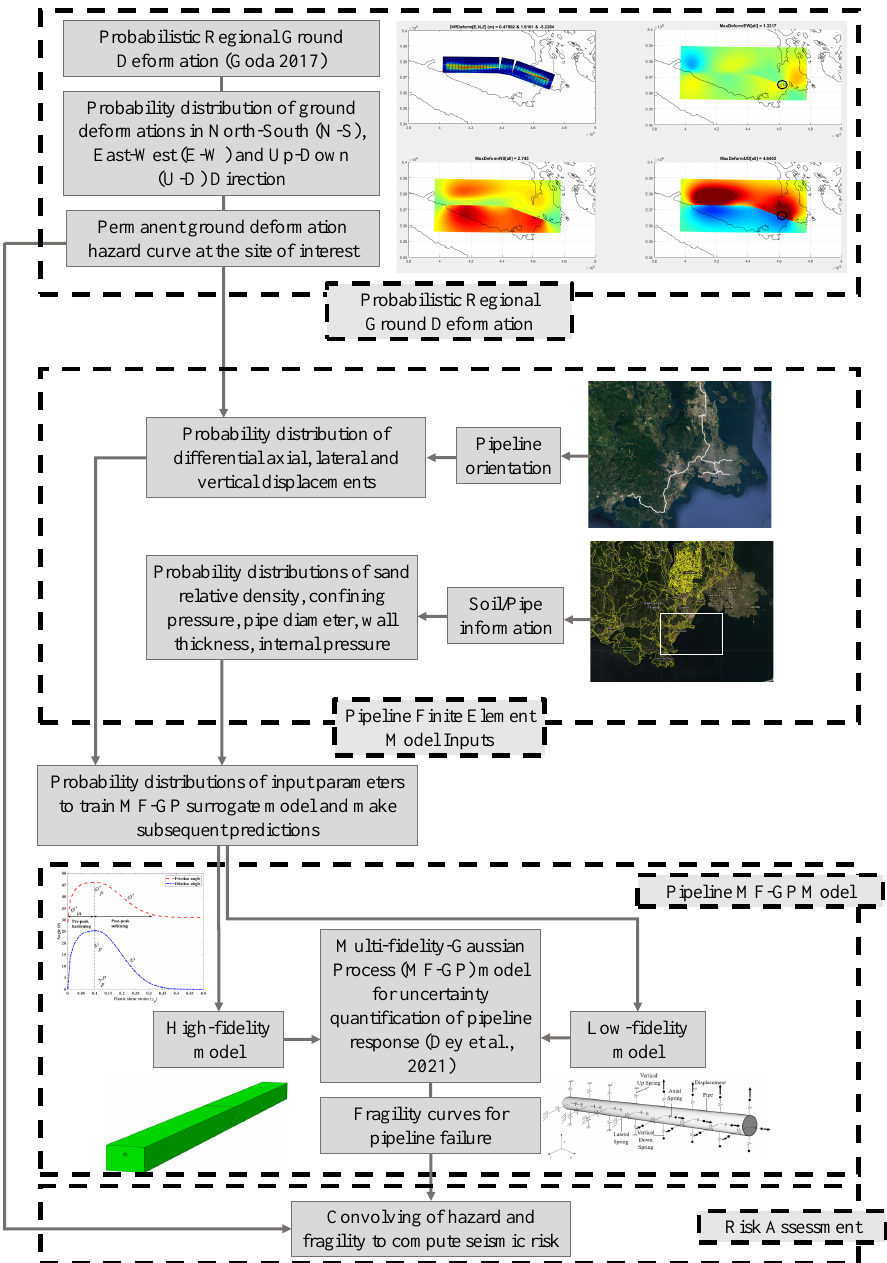
Figure 1. Integration of regional probabilistic ground deformation with pipeline response uncer- tainty